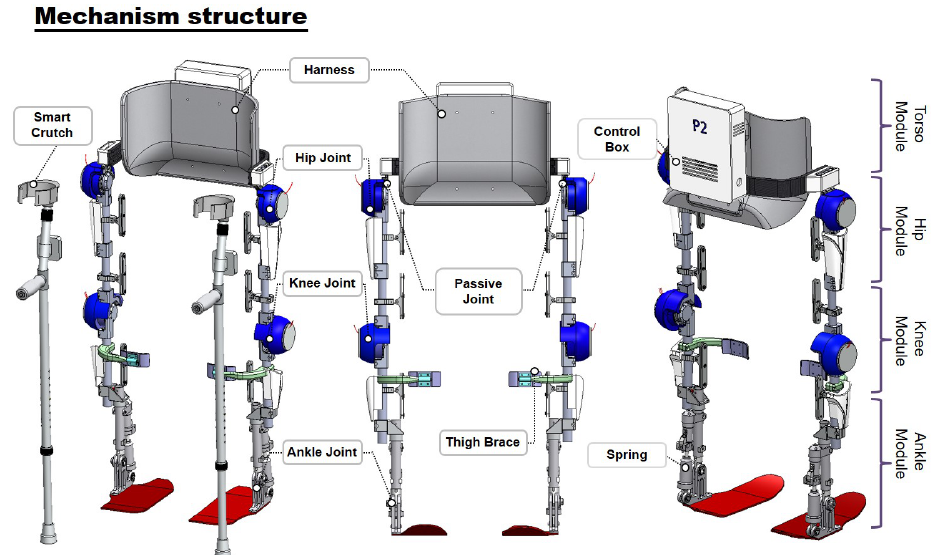
Figure 9. Our exoskeleton robot has four active and two passive joints in the sagittal plane. The four active joints assist the hip and knee flexion and extension motion. The two passive joints can realize free movements on ankle plantar flexion and dorsi flexion. In the frontal plane, for hip abduction and adduction movements, we design one passive joint for both the right and left